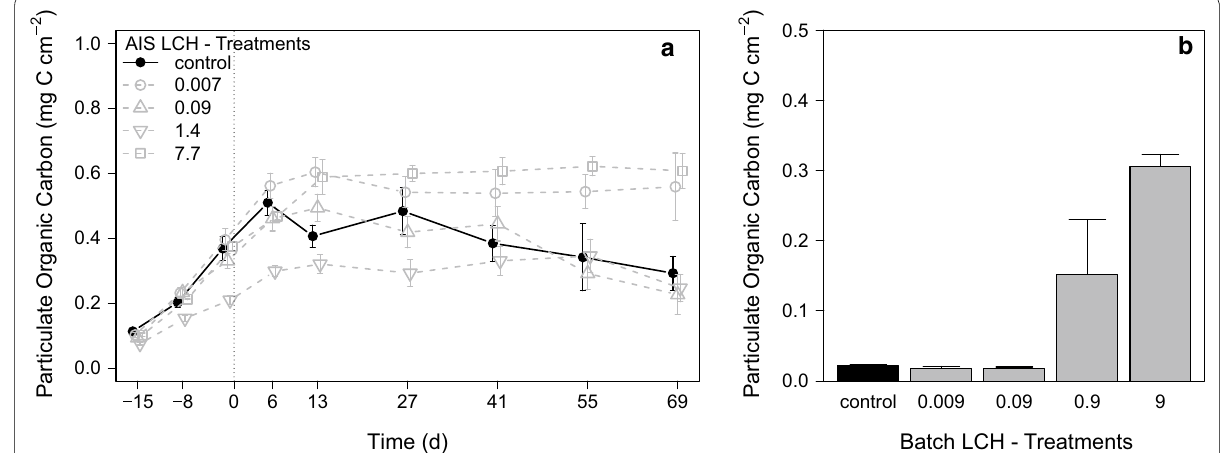
Fig. 7 Aufwuchs biomass during a LCH AIS experiment [mean